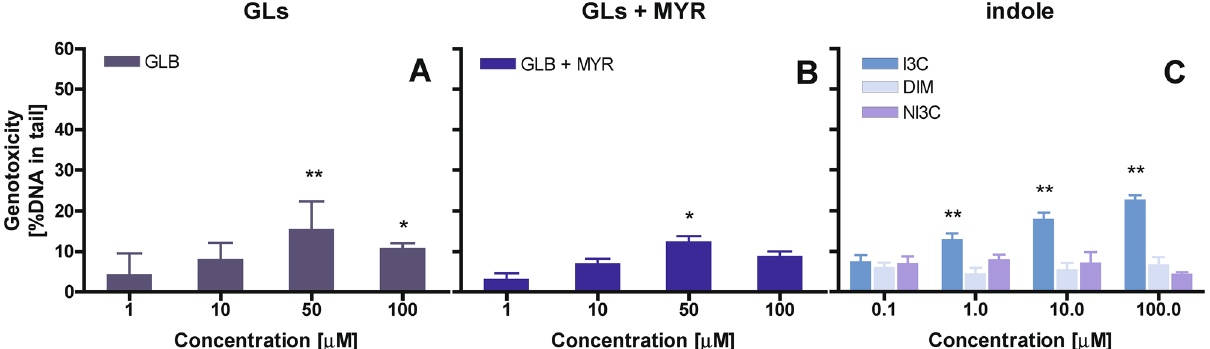
Figure 6. Genotoxic effect in HT29 cells determined for ( A ) glucosinolate–glucobrassicin (GLB) and GLB in the presence of myrosinase (GLB + MYR); ( B ) products of GLB hydrolysis—indole-3-carbinol (I3C), its dimer— diindolylmethane (DIM) and ( C ) neoglucobrassicin (neoGLB) hydrolysis product— N -methoxy-indole-3- carbinol (NI3C). As negative control served the cells treated with pure water instead of tested compounds (± 5% DNA in tail); as positive control served the cells treated with 100 µM H 2 O 2 (± 80% DNA in tail). The results represent means ± SD of three independent determinations. Significantly different values determined by one- way analysis of variance (ANOVA) with Dunnett’s post-test are marked as *p < 0.05, **p < 0.01.